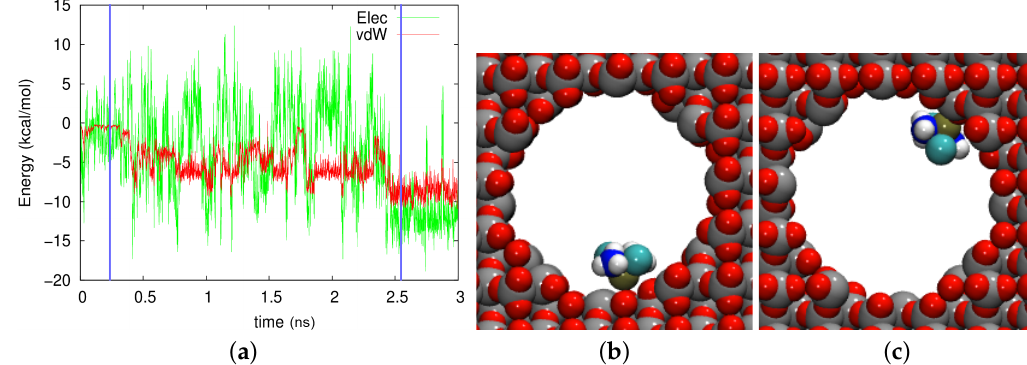
Figure 7. ( a ) Evolution of the electrostatic (Elec) and vdW energies between the cisplatin molecule and the axial cristobalite pore during the diffusion process. ( b , c ) show snapshots at times of ( b ) 433 ps and ( c ) 2572 ps. These times are marked in ( a ) by vertical blue lines.